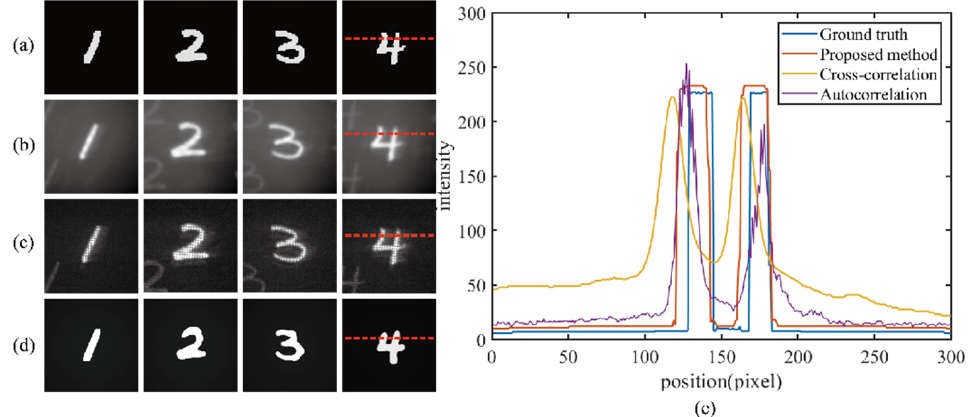
Figure 9. Comparison between the proposed method and the correlation algorithm. ( a ) Ground truth; ( b ) Result of the cross-correlation algorithm; ( c ) Result of the autocorrelation algorithm; ( d ) Result of the proposed strategy; ( e ) Profiles of the dashed red lines in ( a – d ).